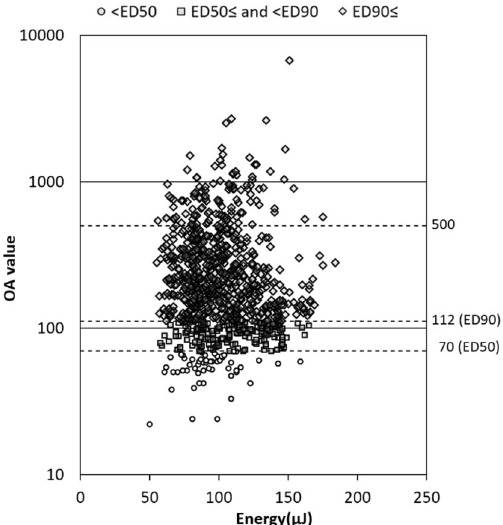
Figure 3. SRT irradiation energy and optoacoustic (OA) values. The scatter plot shows the correspondence between irradiation energy and optoacoustic value at each irradiation spot in all cases.